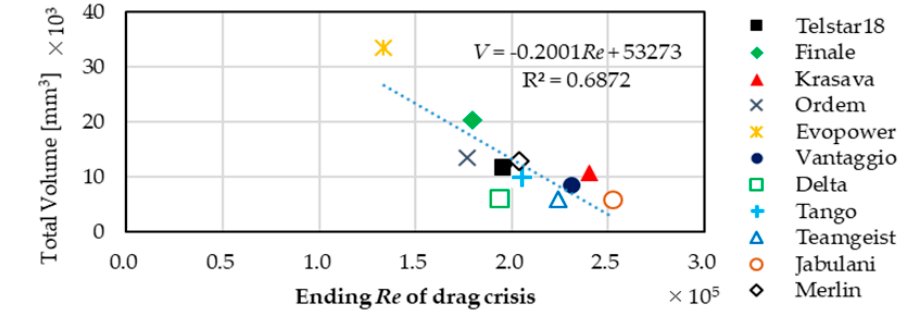
Figure 3. The relation between the Ending Re of drag crisis and total groove volume.